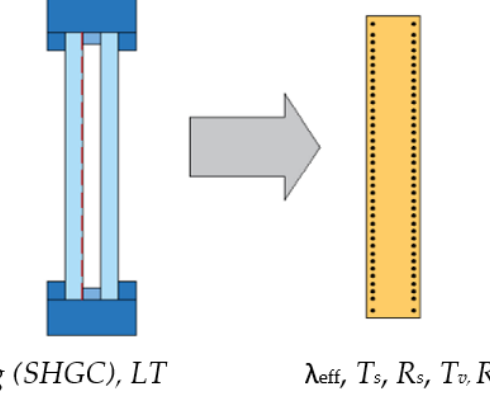
Figure 6. Simplification of whole window properties into simple layer properties in the EnergyPlus (own elaboration based on [36]), where λ eff is the effective conductivity of the glazing system, T s is the solar transmittance of the glazing system, at normal incidence, R s is the lateral side solar reflectance, at normal incidence, T v is the visible reflectance, at normal incidence, and R v is the lateral side visible reflectance, at normal incidence. After generating the layer properties, the layer-by-layer model is used for further calcula- tions. The properties of the equivalent layer are determined using the step-by-step method outlined by Arasteh et al. [37]. At the beginning, the resistance of the glass itself R l,w is determined ( w denotes without the coefficients of the films (coatings)) using Equation (11).